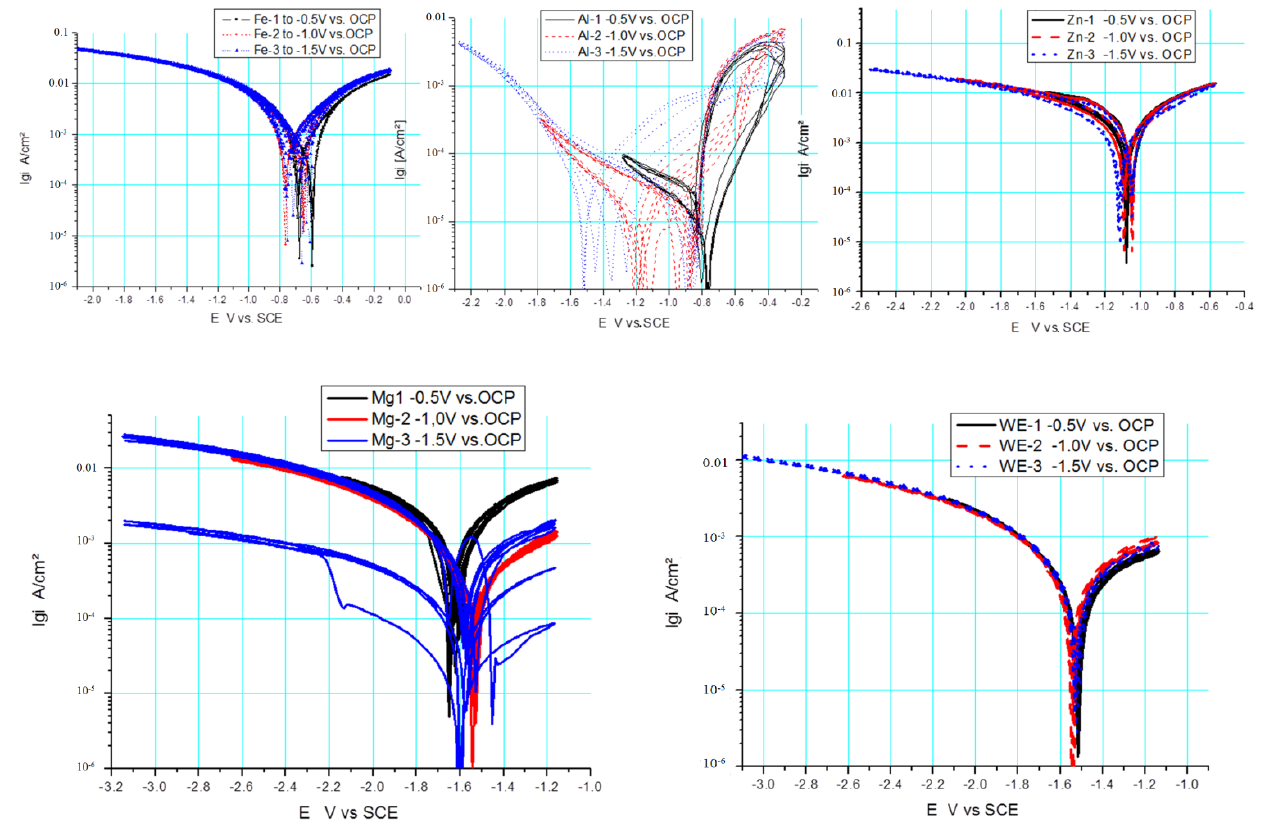
Figure 2. Cyclic current ( I ) vs. voltage ( E ) curves of different elements (Zn, Fe, Mg) and alloy WE43 in Ringer solution; scan rate: 100